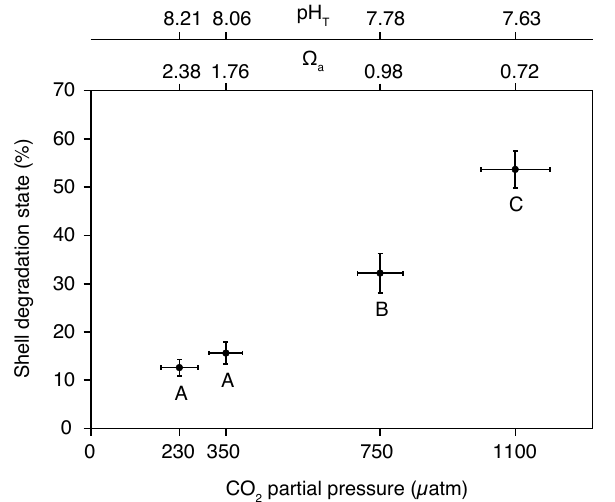
Fig. 3. Percent shell degradation of Limacina helicina after 29 days of incubation. Mean for the effect of p CO 2 . Vertical bars denote 0.95 confidence intervals for shell degradation while horizontal bars denote 0.95 confidence intervals for p CO 2 . Results from PER- MANOVA pair-wise tests are depicted by letters with levels not connected by same letter being significantly different.